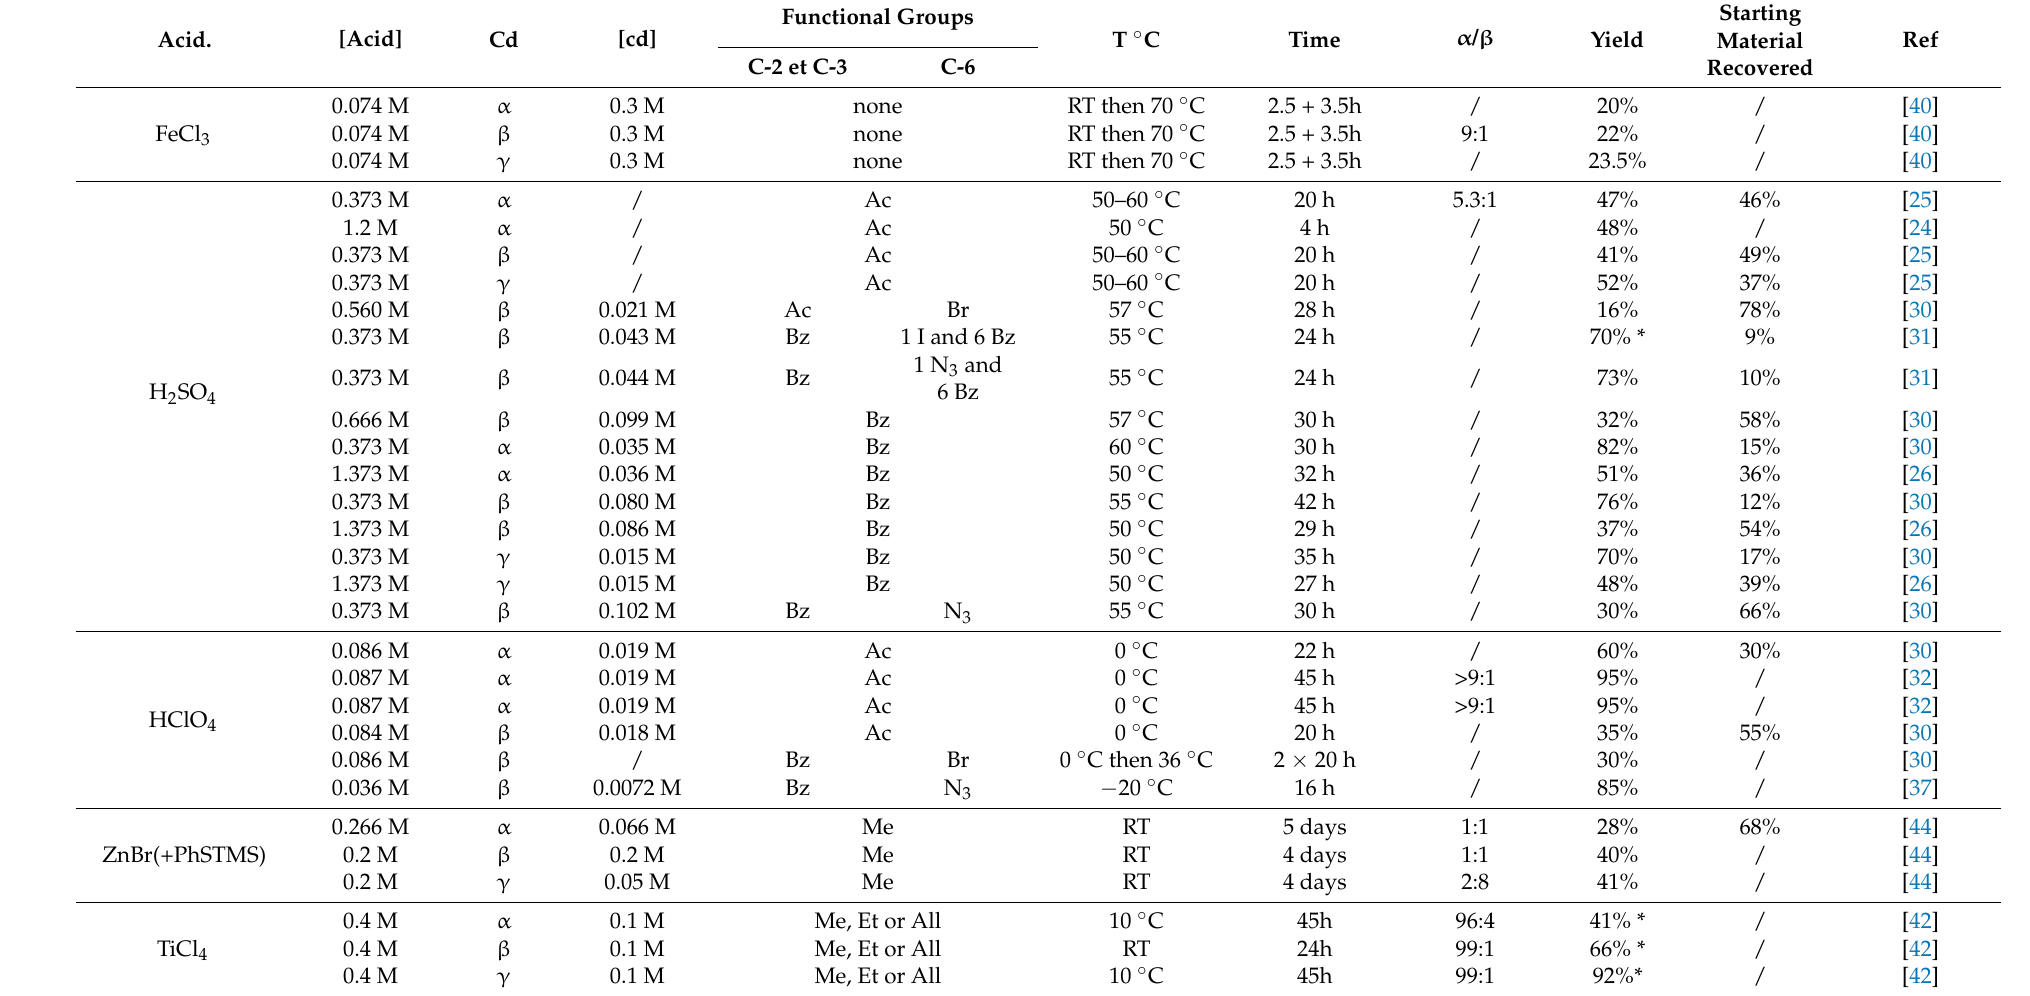
Table 2. Conditions for ring-opening of CD (* mixture of